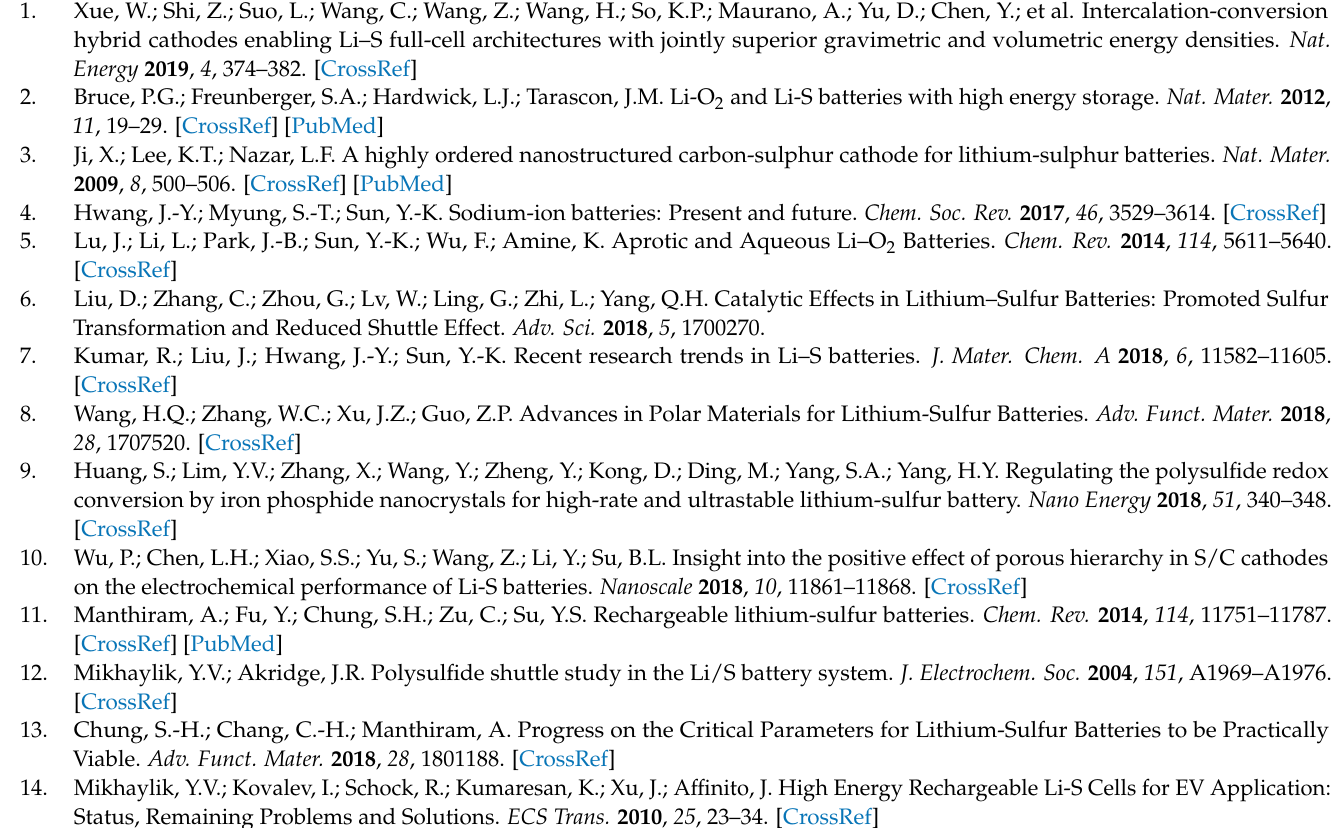
Supplementary Materials: The following are available online. Figure S1: (a) SEM images of CNT interlayer with EDS mapping images of carbon, tungsten, oxygen. (b) Isotherm profiles and (c) pore size distributions of WNW. Figure S2: (a) Cycling performance and (b) voltage profiles of a lithium- sulfur cell without an interlayer. Figure S3: Cyclic voltammetry curves of the lithium-sulfur cells with a (a) WNW/CNT interlayer and (b) CNT interlayer, respectively, at different scan rates. Figure S4: (a) Cycling performances of the interlayers without sulfur electrodes. (b) Cyclic voltammetry (CV) profiles of WNW (1.5–3.8 V). Table S1: Comparison of overall electrochemical performances previously reported lithium-sulfur batteries incorporating different types of interlayer or functional